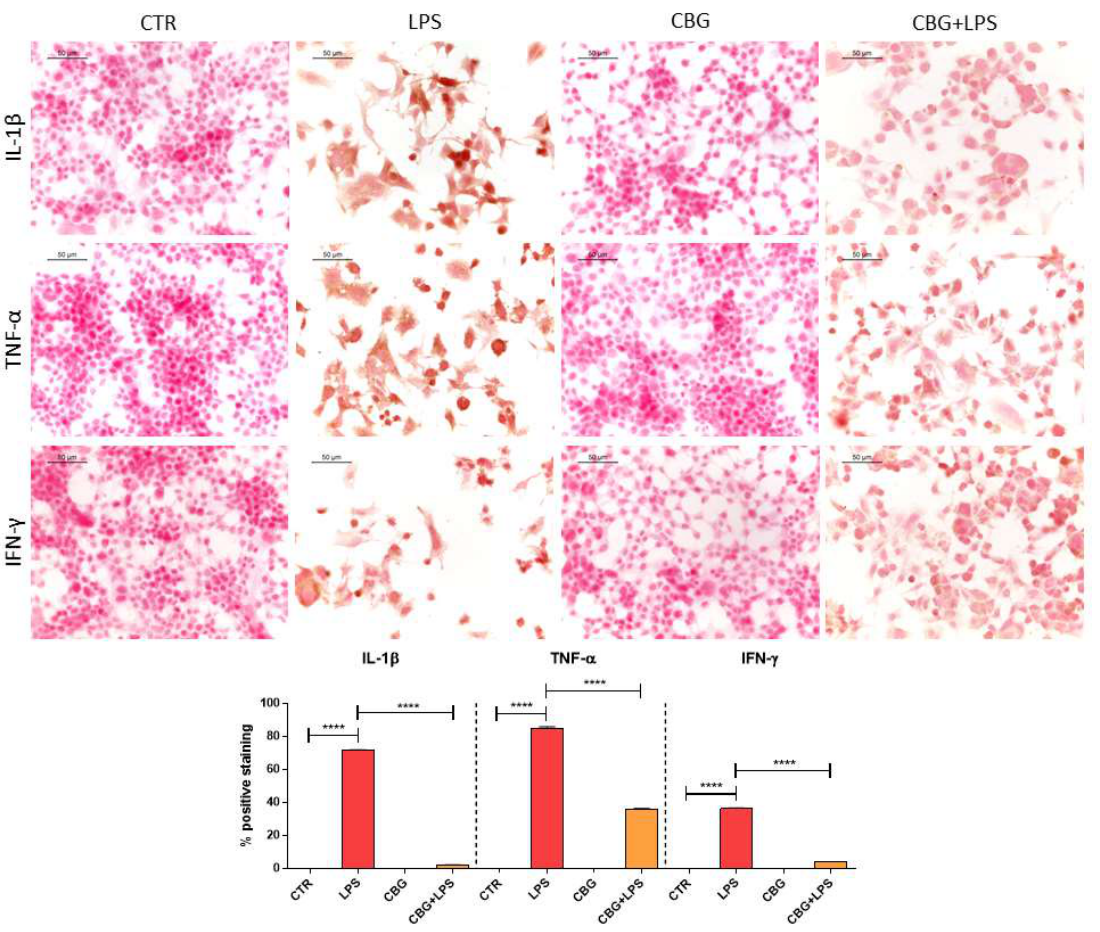
Figure 3. CBG pre-treatment was able to reduce the levels of pro-inflammatory cytokines in NSC-34 cells treated with the medium of LPS-stimulated RAW 264.7 macrophages. Immunocytochemistry with the quantitative analysis of positive staining showed that the treatment with the medium of LPS-stimulated RAW 264.7 macrophages induced the expression of the pro-inflammatory cytokines IL-1 β , TNF- α and IFN- γ . CBG pre-treatment reduced the protein levels of the pro-inflammatory cytokines. The immunocytochemical assays were repeated three times. **** p < 0.0001, NSC-34 cells treated with the medium of LPS stimulated macrophages vs. NSC-34 pre-treated with CBG and then exposed to the medium of LPS stimulated macrophages, NSC-34 treated with the medium of LPS stimulated macrophages vs. control; Scale bar: 50 µm.